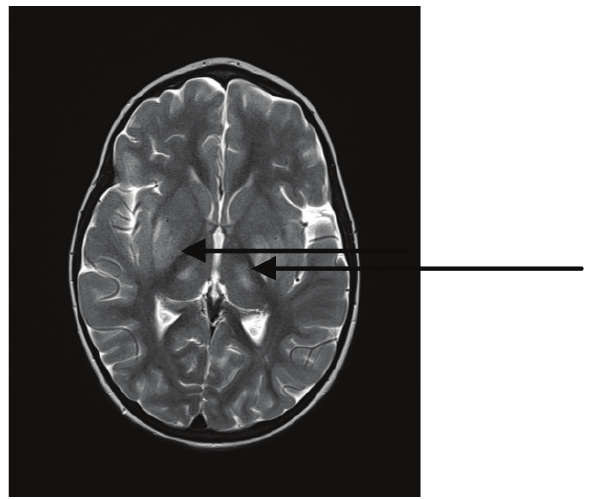
Figure 4. MRI scan of brain recorded on the 12th day of disease: bilateral hyperintensity in lateral thalamic regions